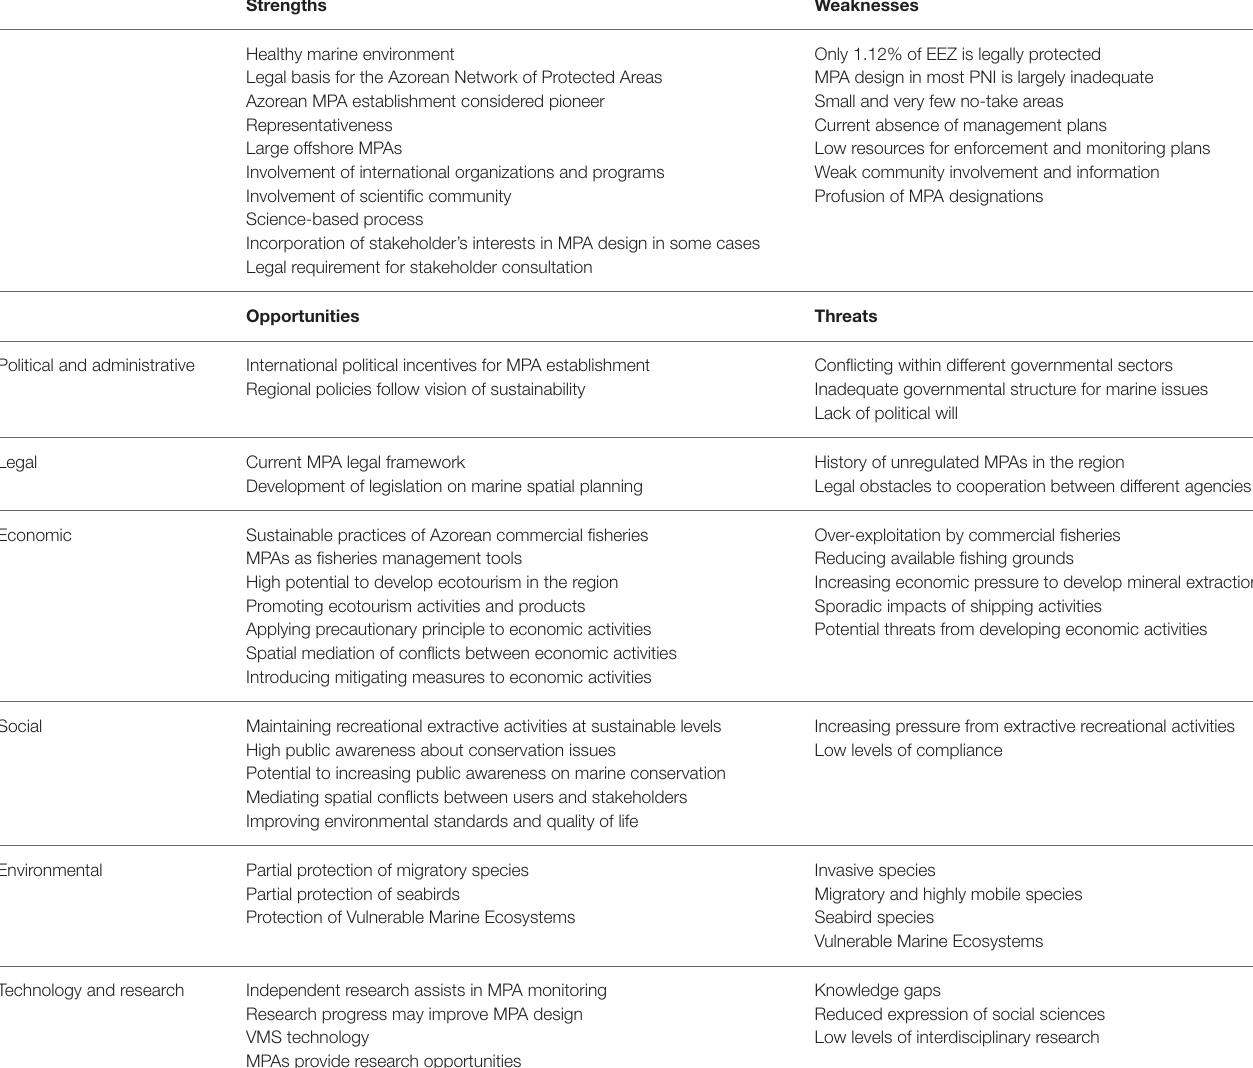
TABLE 3 | Summary of the critical analysis of the current Azorean MPA network, including identified internal factors (strengths and weaknesses) and external factors (opportunities and threats provided by the different PESTLE factors: political and administrative, legal, economic, social, environmental, and technology and